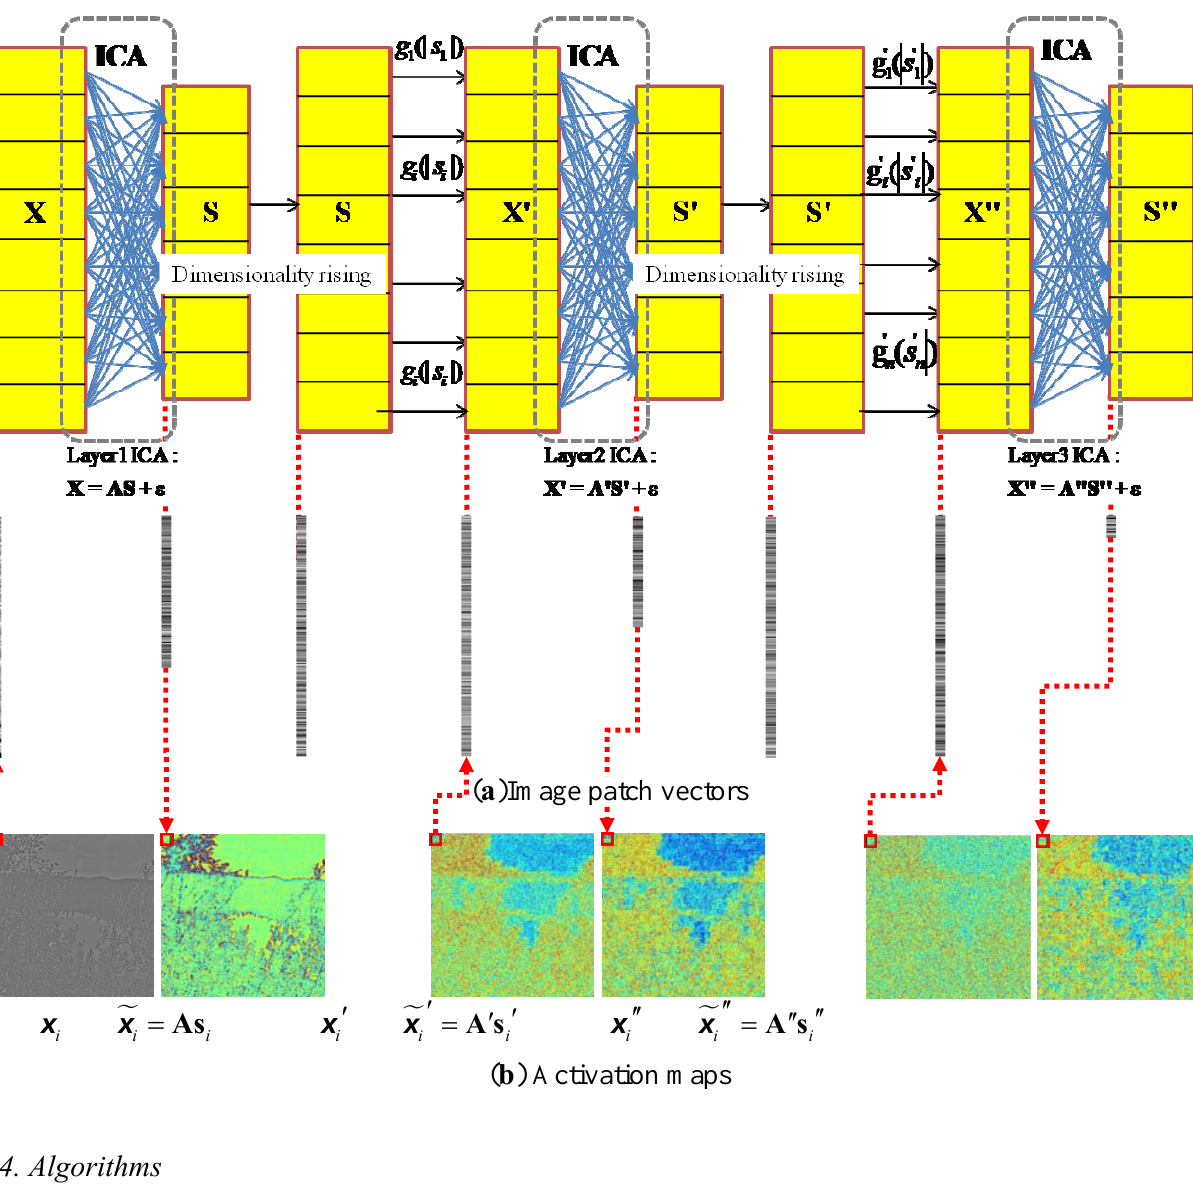
Figure 4. The hierarchical ICA architecture. ( a ) Image patch vectors; ( b ) Activation